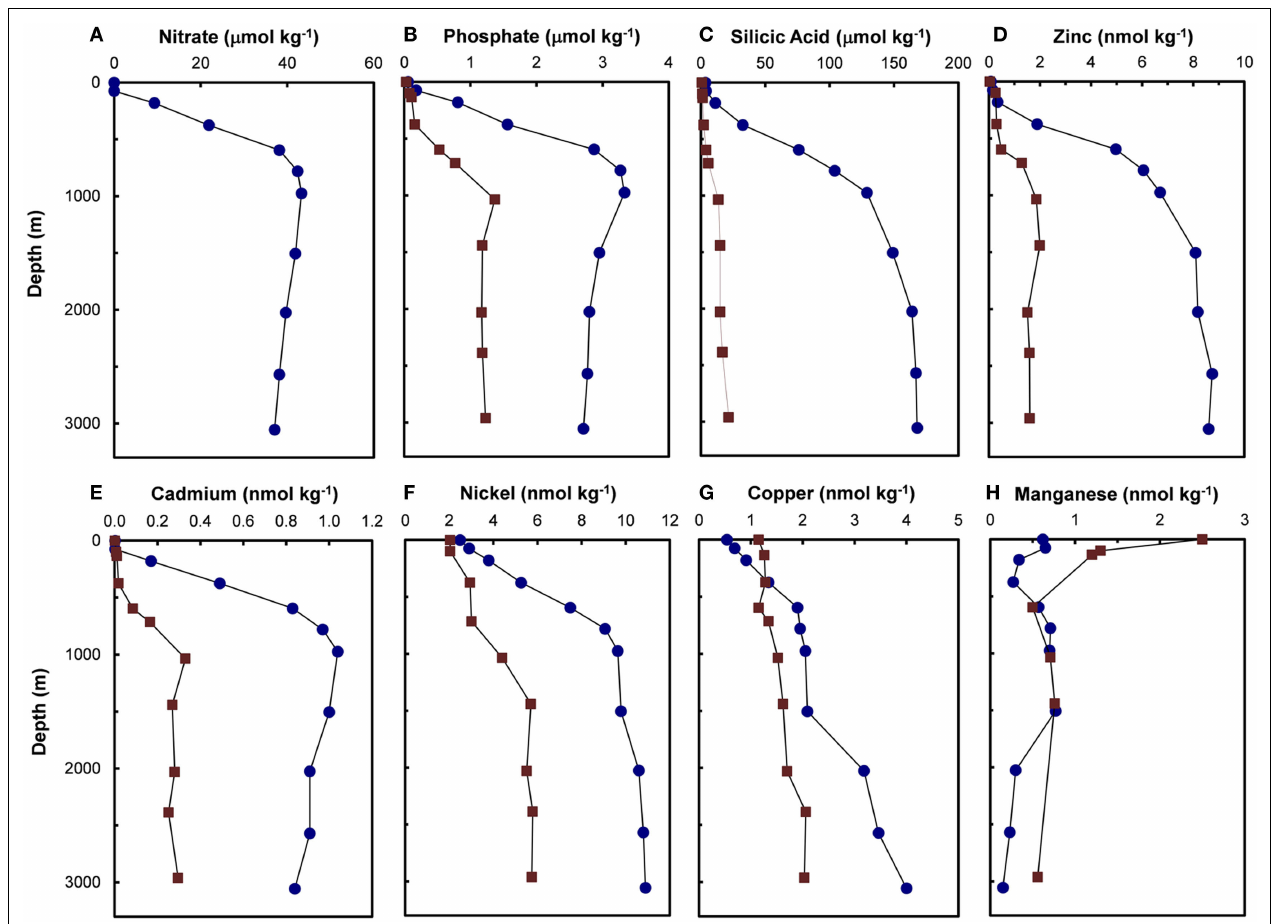
FIGURE 2 | Depth profiles for major nutrients (A–C) [nitrate (Pacific only), phosphate, and silicic acid] and filterable concentrations (that passing a 0.4- μ m filter) of trace metal nutrients (D–H) (Zn, Cd, Ni, Cu, and Mn) in the central North Pacific ( Atlantic ( (cid:2) , 34.1˚N, 66.1˚W, July 1979; Bruland and Franks, 1983). Manganese concentrations in the Pacific were analyzed in acidified, unfiltered seawater